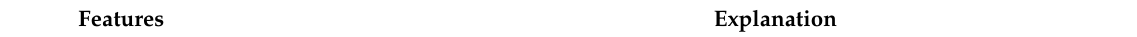
Workout Sessions with